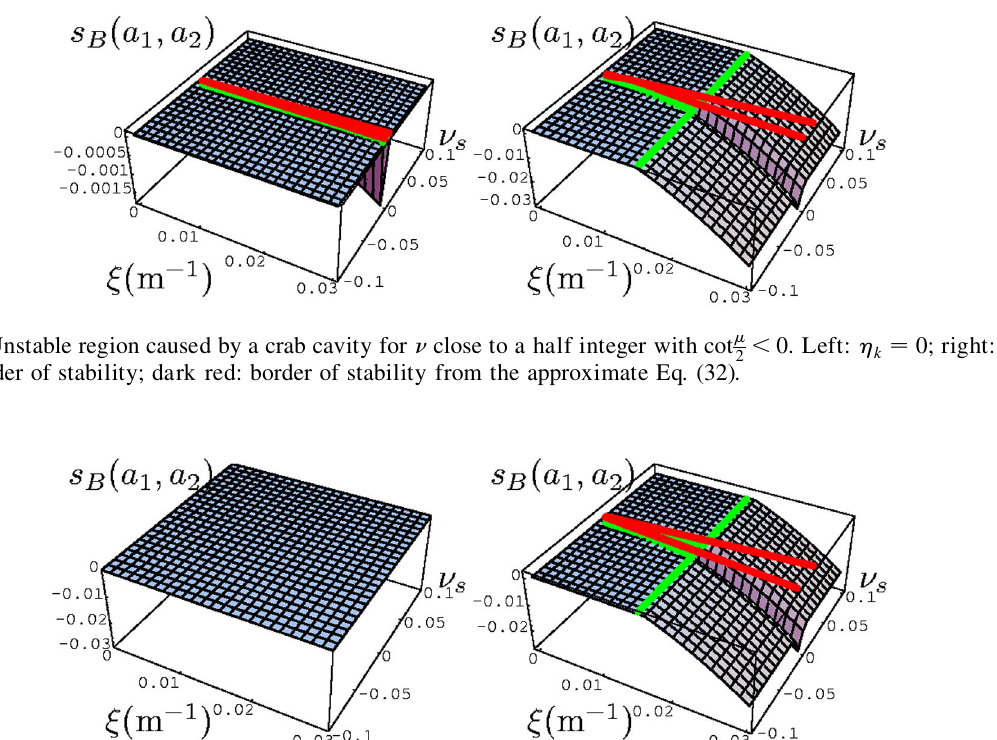
(cid:2) 0 ; right: (cid:22) (cid:2) 4 m . > 0 . Left: (cid:22) k k 2